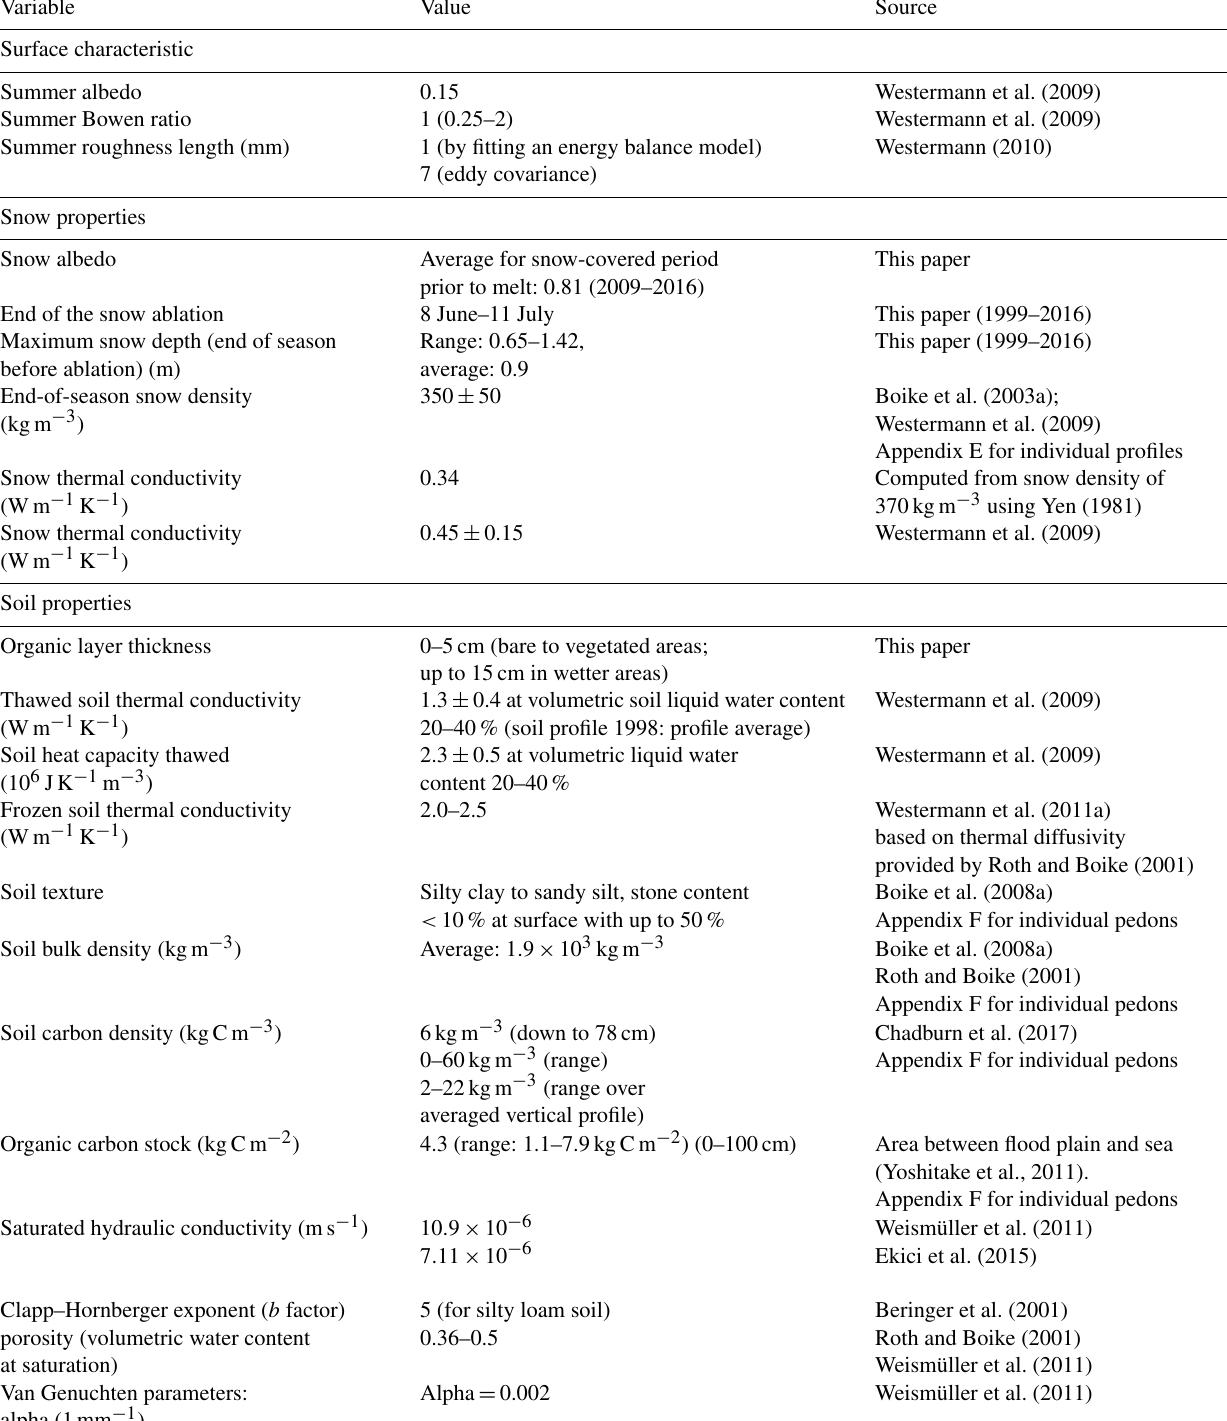
Table 1. Site description parameter for earth system model input. Values have been computed and compiled for the Bayelva site and sur- rounding